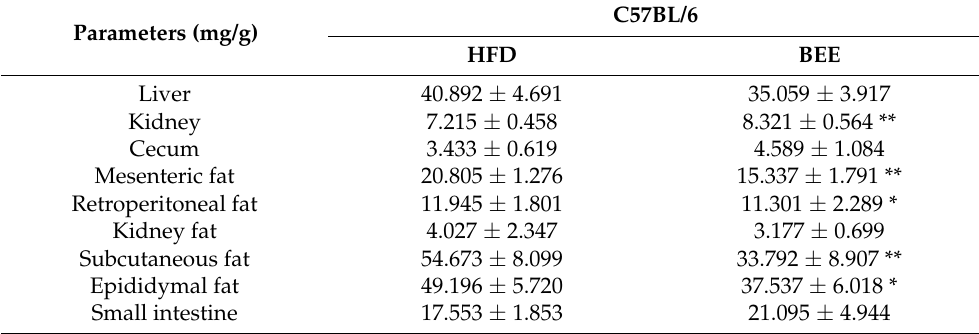
Figure 3. Comparison of total cholesterol ( a ), triglyceride ( b ), HDL ( c ), and LDL ( d ) contents with or without administration of BEE. Each point represents mean ± S.D. ( n = 10). Triglyceride, total cholesterol, HDL, LDL contents were compared between control (HFD) and treatment group (BEE) at each time point by unpaired Student’s t -test (* p < 0.05; ** p < 0.01). Table 2. Effects of BEE treatment on various organs and adipose tissue weight in C57BL/6.